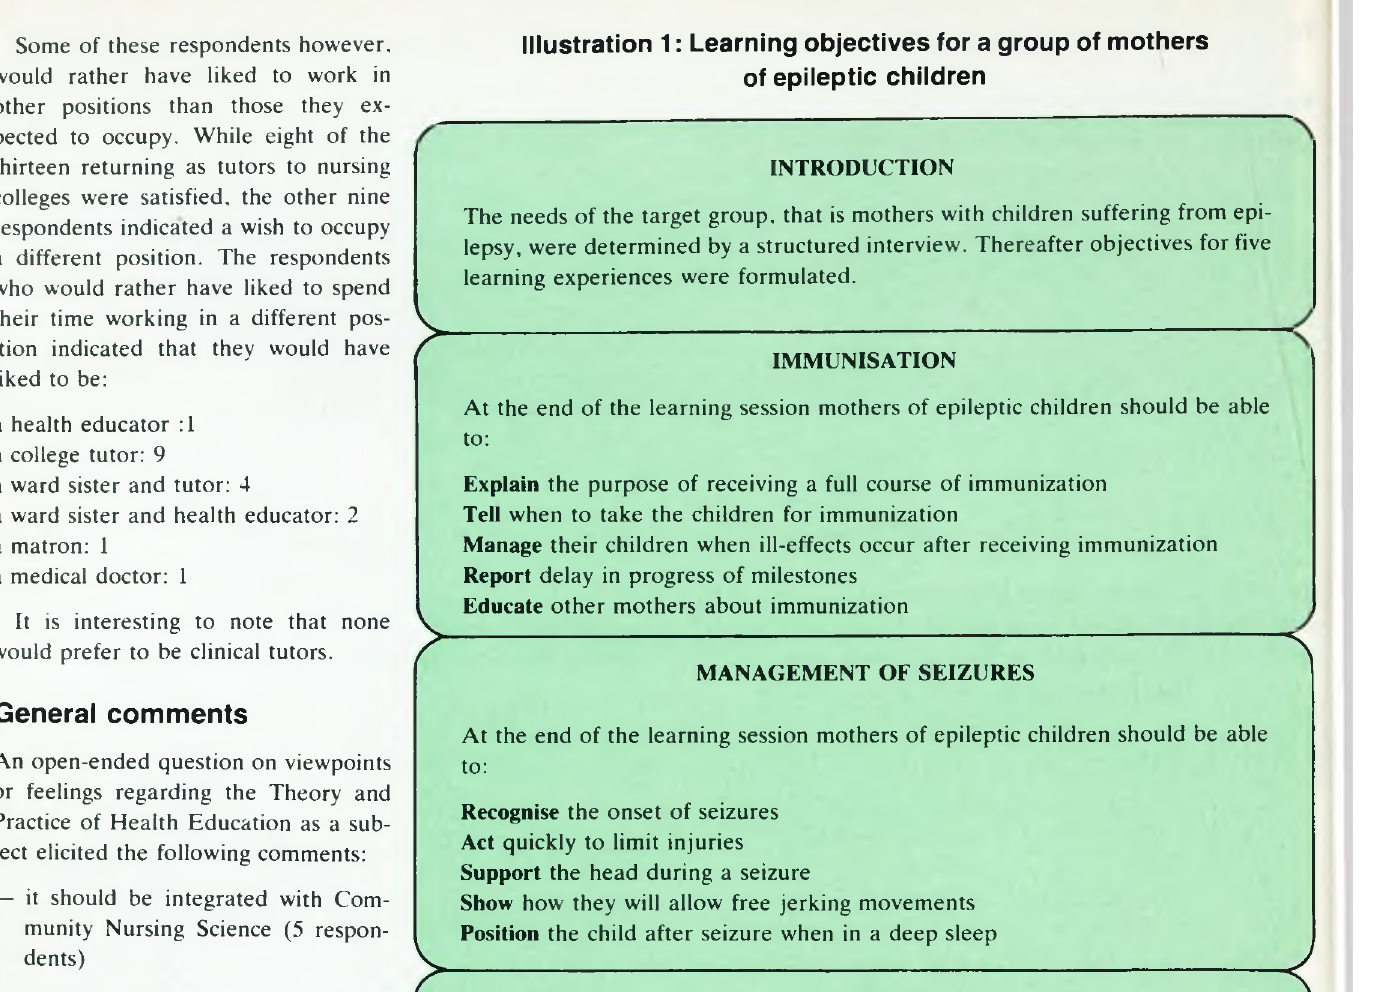
Illustration 1: Learning objectives for a group of mothers of epileptic